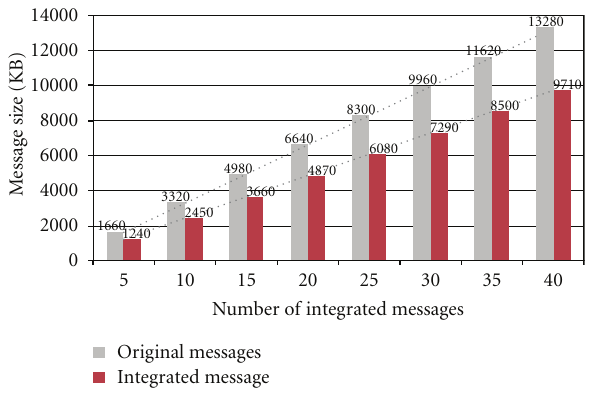
Figure 7: Sizes of integrated messages.